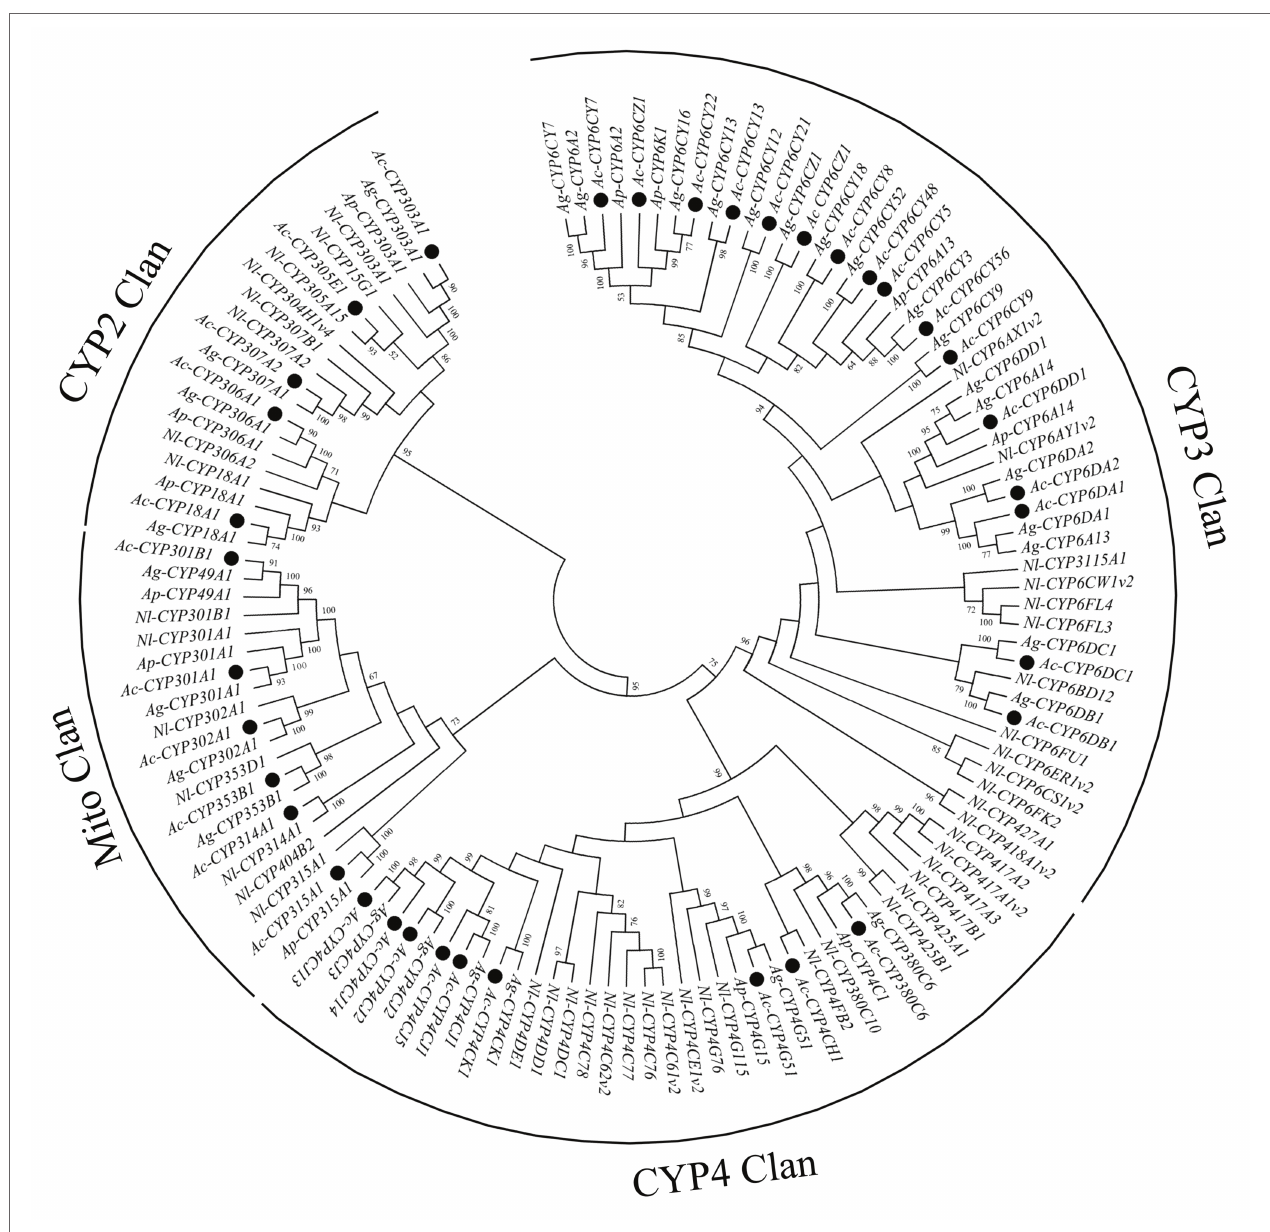
FIGURE 1 | Phylogenetic analysis of P450 genes. The numbers above the branches indicate the support for the phylogenies, and only values above 50% are shown. Blackened circles indicate the Aphis craccivora position. Ac, A. craccivora ; Ag, Aphis gossypii ; Ap, Acyrthosiphon pisum ; Nl, Nilaparvata lugens